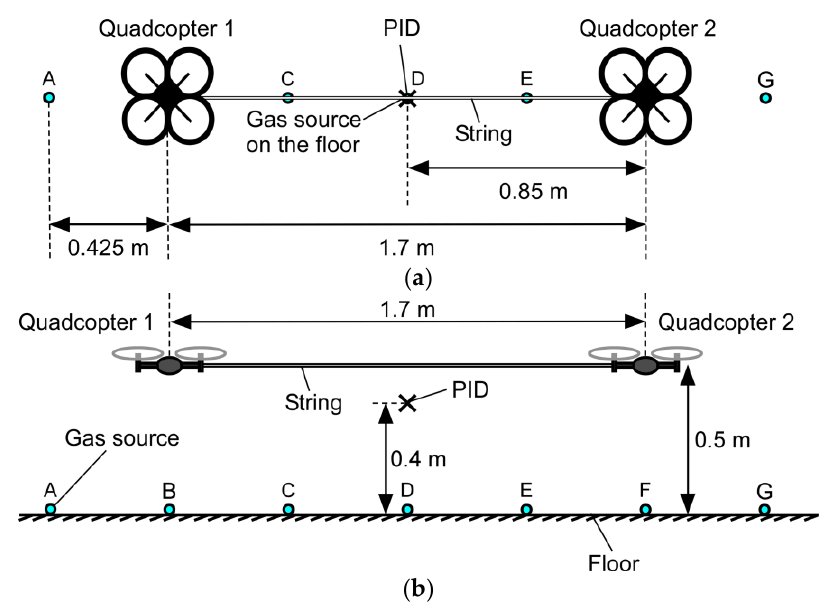
Figure 7. Experimental setup to investigate the range of gas detection along the two quadcopters. ( a ) Top view; ( b ) side view. The position of the gas source was moved from point A through points B–F to point G.